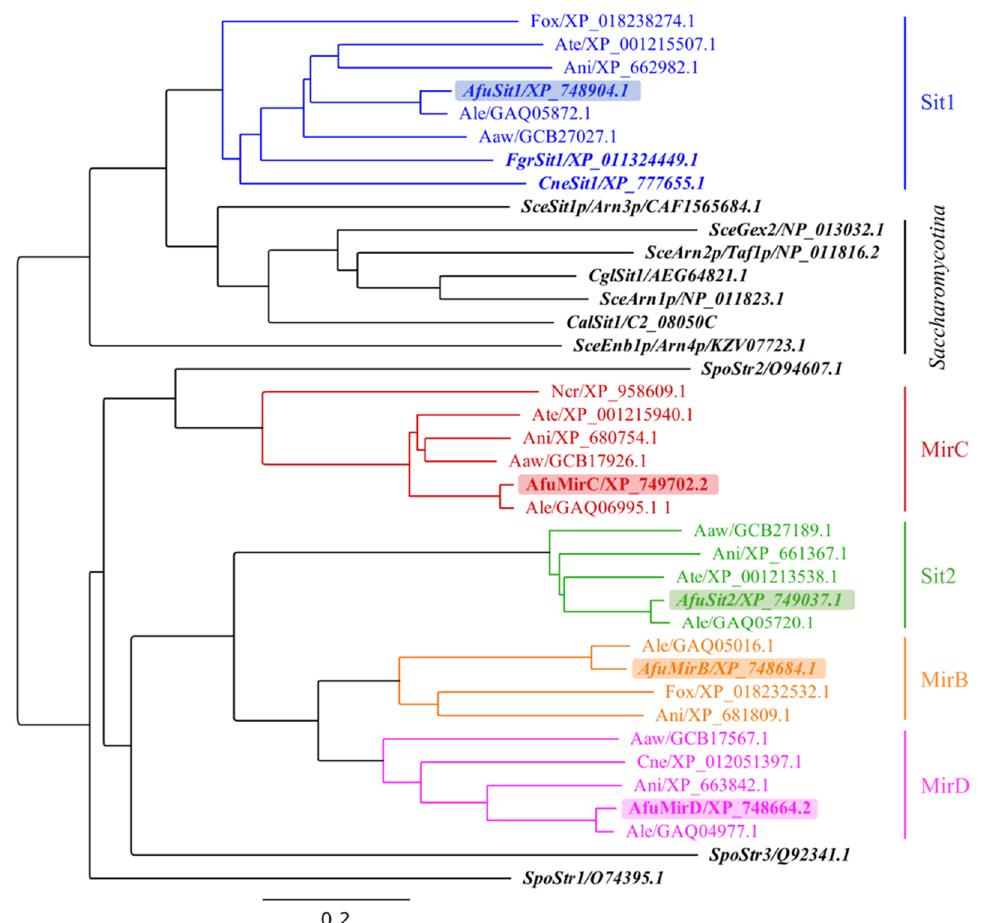
Figure 3. Phylogenetic analysis of selected SITs. Phylogenetic analysis was conducted with 38 SITs from Aspergillus fumigatus (Afu), Aspergillus nidulans (Ani), Aspergillus lentulus (Ale), Aspergillus awamori (Aaw), Aspergillus terreus (Ate), Fusarium oxysporum (Fox), Fusarium graminearum (Fgr), Schizosaccharomyces pombe (Spo) , Saccharomyces cerevisiae (Sce), Neurospora crassa (Ncr) , Cryptococcus neoformans (Cne), Candida albicans (Cal) and Candida glabrata (Cgl). Protein sequences alignment and neighbor-joining tree building were performed using the software Geneious Prime 2021.2.2 [43] (Scale bar is the percentage of genetic variation). SITs with identified substrates are in italics, SITs from A. fumigatus are shaded in different colors. The underlying multiple alignments for the corresponded sequences is displayed in Figure S7.